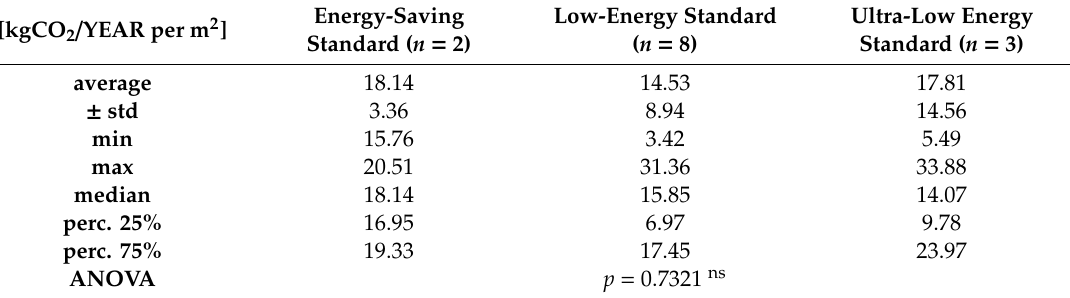
Table 9. Annual CO 2 production in relation to heating categorized according to energy standards calculated per m 2 of useful floor area of the analyzed log wood